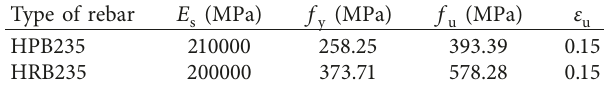
Table 1: The parameters of the CEB-FIP bond-slip model.